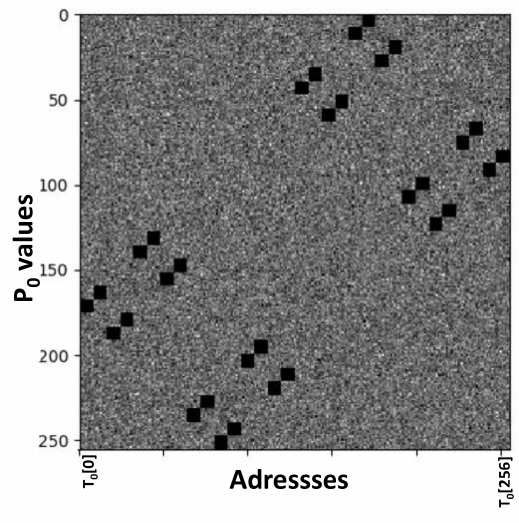
Figure 11. Cache access pattern to T 0 table using a Evict+Time attack from the programmable logic part, frequency = 250